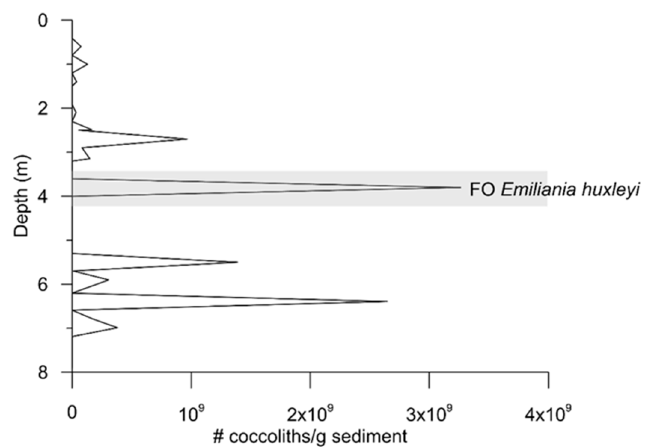
Figure 14. Absolute abundance of small Gephyrocapsa morphotypes from 0 to 8 mbsf. Gray highlighted area estimates an acme interval of the nannofossil. The secondary event coincides with the first occurrence of Emiliania huxleyi , which also lies within the gray area.